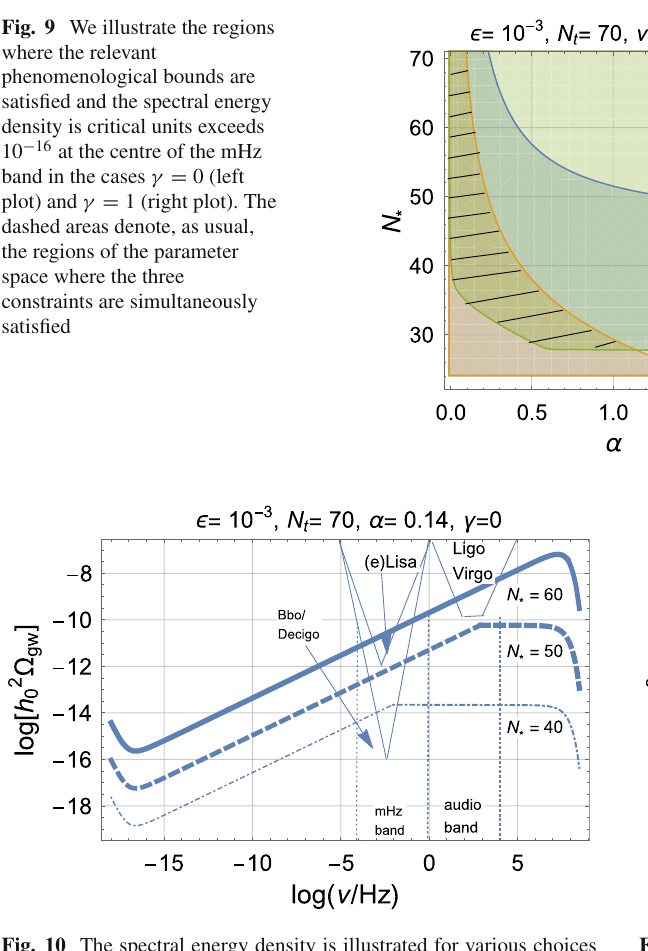
Fig. 10 The spectral energy density is illustrated for various choices of N ∗ with N ∗ < N t . The other values have been selected within the allowed regions of the parameter space and they are α = 0 . 14 and γ = 0